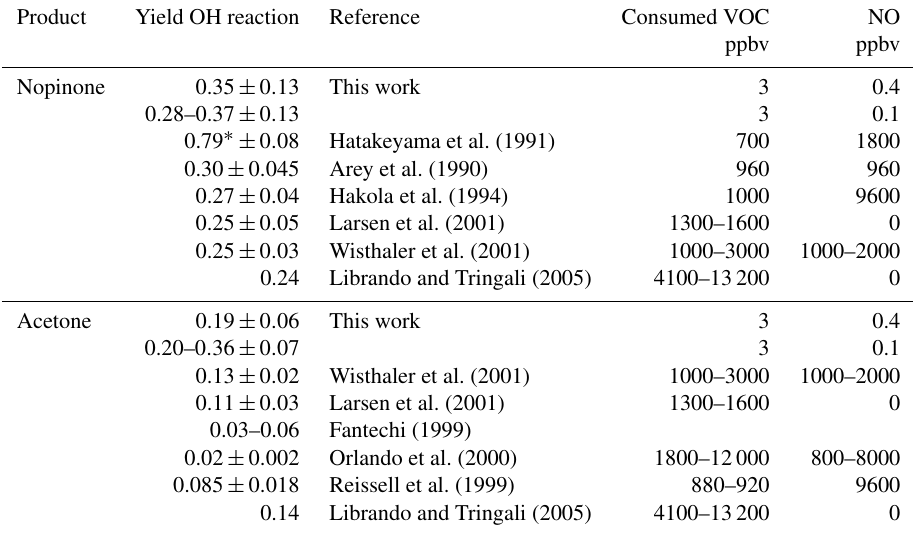
Table 3. Product yields from the reaction of β -pinene with OH radicals under various NO and VOC concentrations